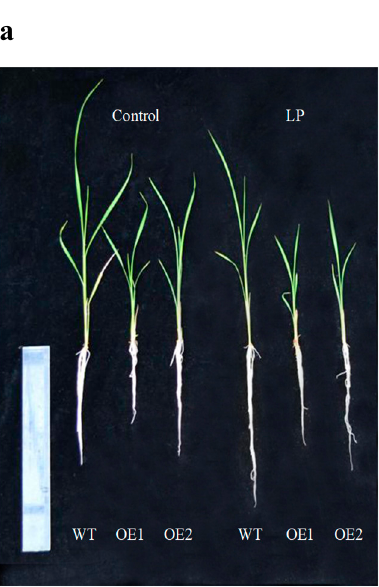
Figure 3. The morphology of the wild type (WT, Nipponbare) and the overexpression of OsPIN2 transgenic plants (OE1/OE2). Seedlings were grown in hydroponic media containing normal nutrition (control, 300 µ M P) or low P (LP, 10 µ M). ( a ) The morphology of rice plants. ( b ) Seminal root (SR) length. Data are means ± SE and bars with different letters indicate significant differences in the same gene ( p < 0.05, ANOVA). All experiments included three independent biological replicates.